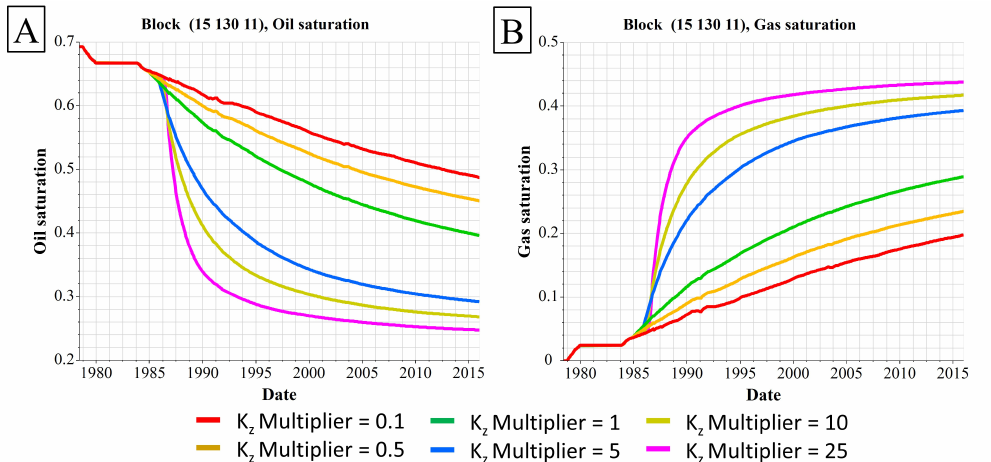
Figure 21. The effect of various vertical permeabilities of the matrix on the oil saturation in the block (15 130 11), hence the oil recovery from the matrix blocks.